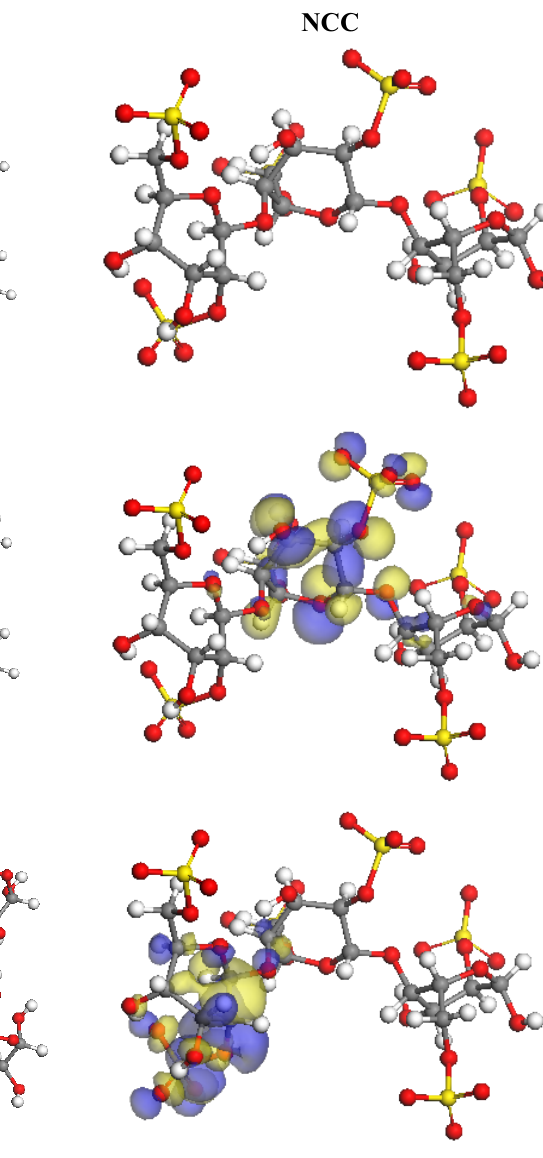
Figure 13. The optimized molecular structures, HOMO and LUMO, of the CEL and NCC using DMol3 module. The ∆ N values evaluate the propensity of a molecule to provide the metal